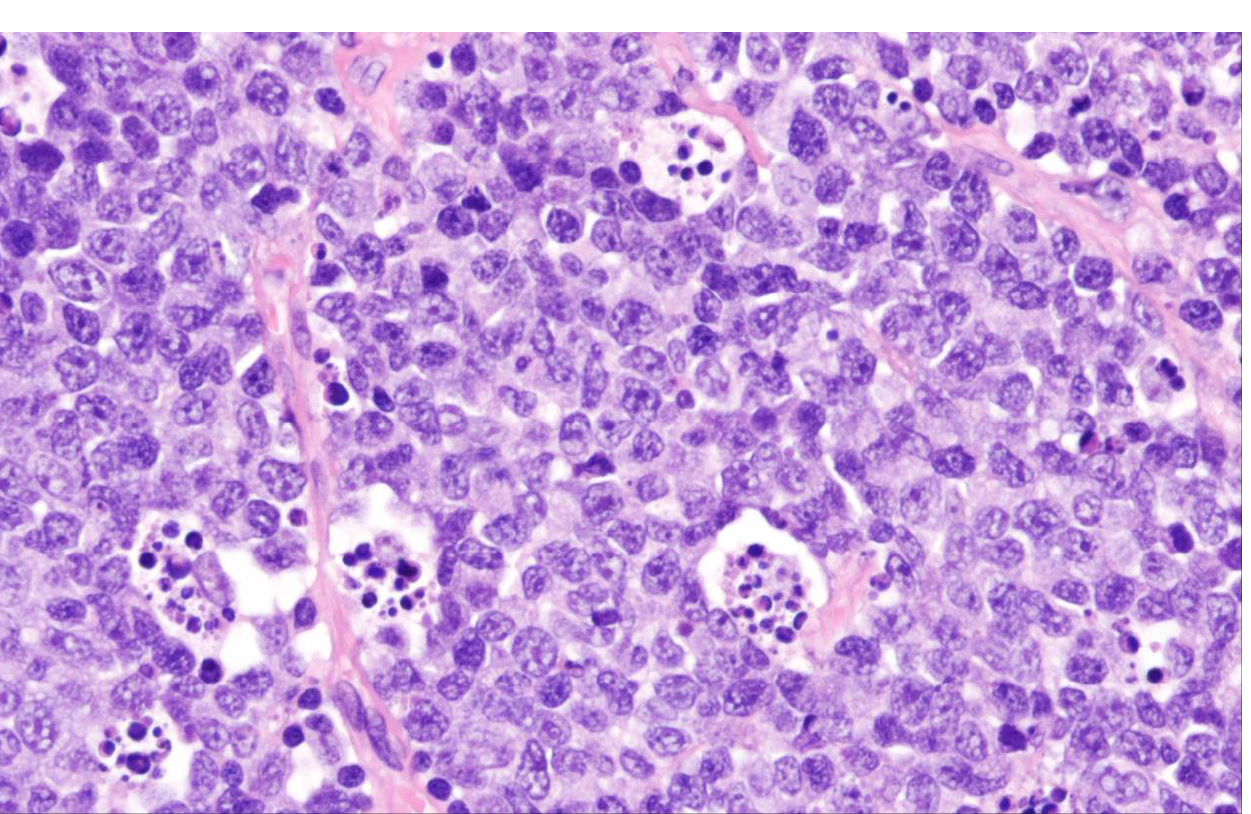
Figure 5. High-grade B-cell lymphoma with 11q aberrations (H&E ×400). These tumors as a rule are composed of medium-sized blastic cells reminiscent of, but more pleomorphic than, those of Burkitt lymphoma. Note the starry sky pattern with coarse cellular debris in the macrophages.